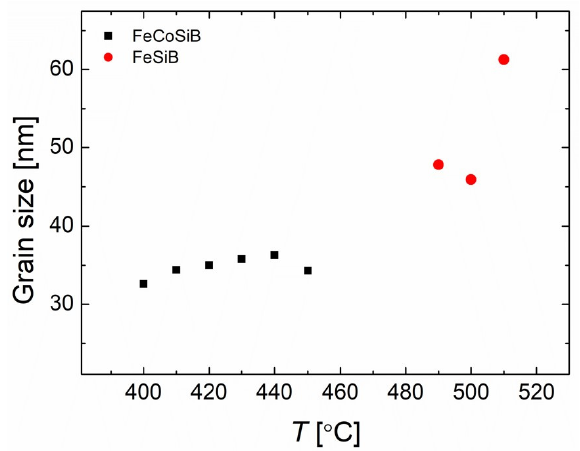
Figure 7. Grain size of FeCoSiB and FeSiB.